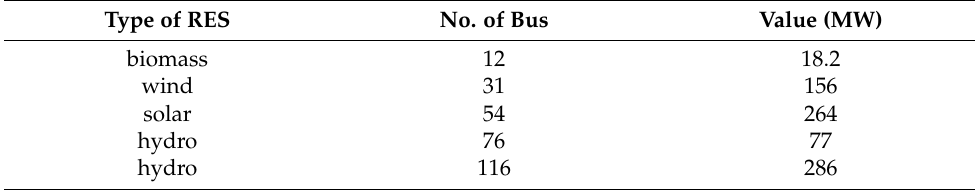
Figure 2. Single-line diagram of the modified IEEE 30-bus test system. Table 2. The location and values of the RES in the IEEE 118-bus test systems.